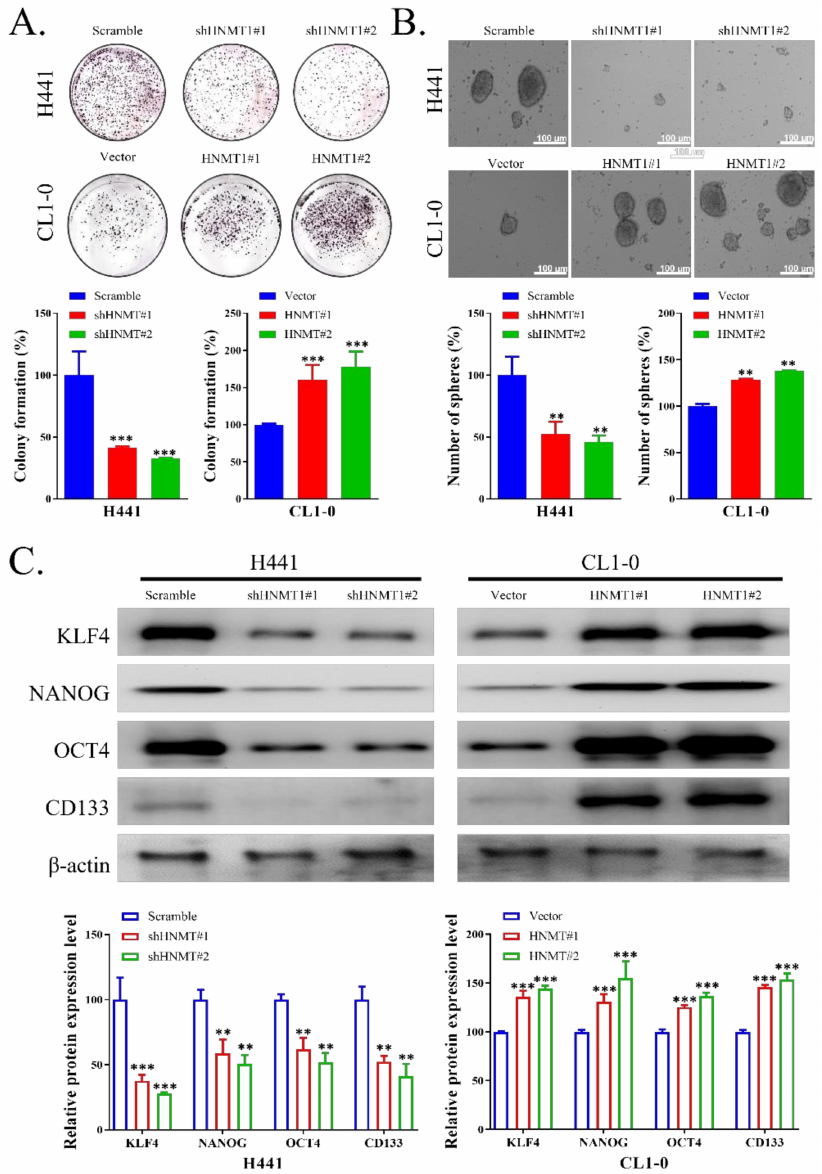
Figure 3. Effects of HNMT on CSCs maintenance in lung cancer cell lines. ( A ) H441 and CL1-0 cells transfected with knockdown and expression vectors were seeded on 6-well plates. Subse- quent to 2 weeks, the colonies were stained with crystal violet, and the number of colonies was counted. ( B ) Tumorsphere formation potential of NSCLC cells. Both H441 and CL1-0 cells could form tumorspheres; HNMT knockdown and overexpression significantly reduced and increased their tumorsphere-forming potential, respectively. ( C ) Cell lysates from the H441 and CL1-0 cells with HNMT knockdown and overexpression were subjected to Western blotting, respectively. HNMT, HER2, HER3, vimentin, and N-cad were detected using their respective antibodies. The experiments were conducted following calibration using β -actin as the internal housekeeping control. The exper- iments were analyzed and normalized across three separate experiments. ** p < 0.01, *** p < 0.001. Scale bar: 100 µ